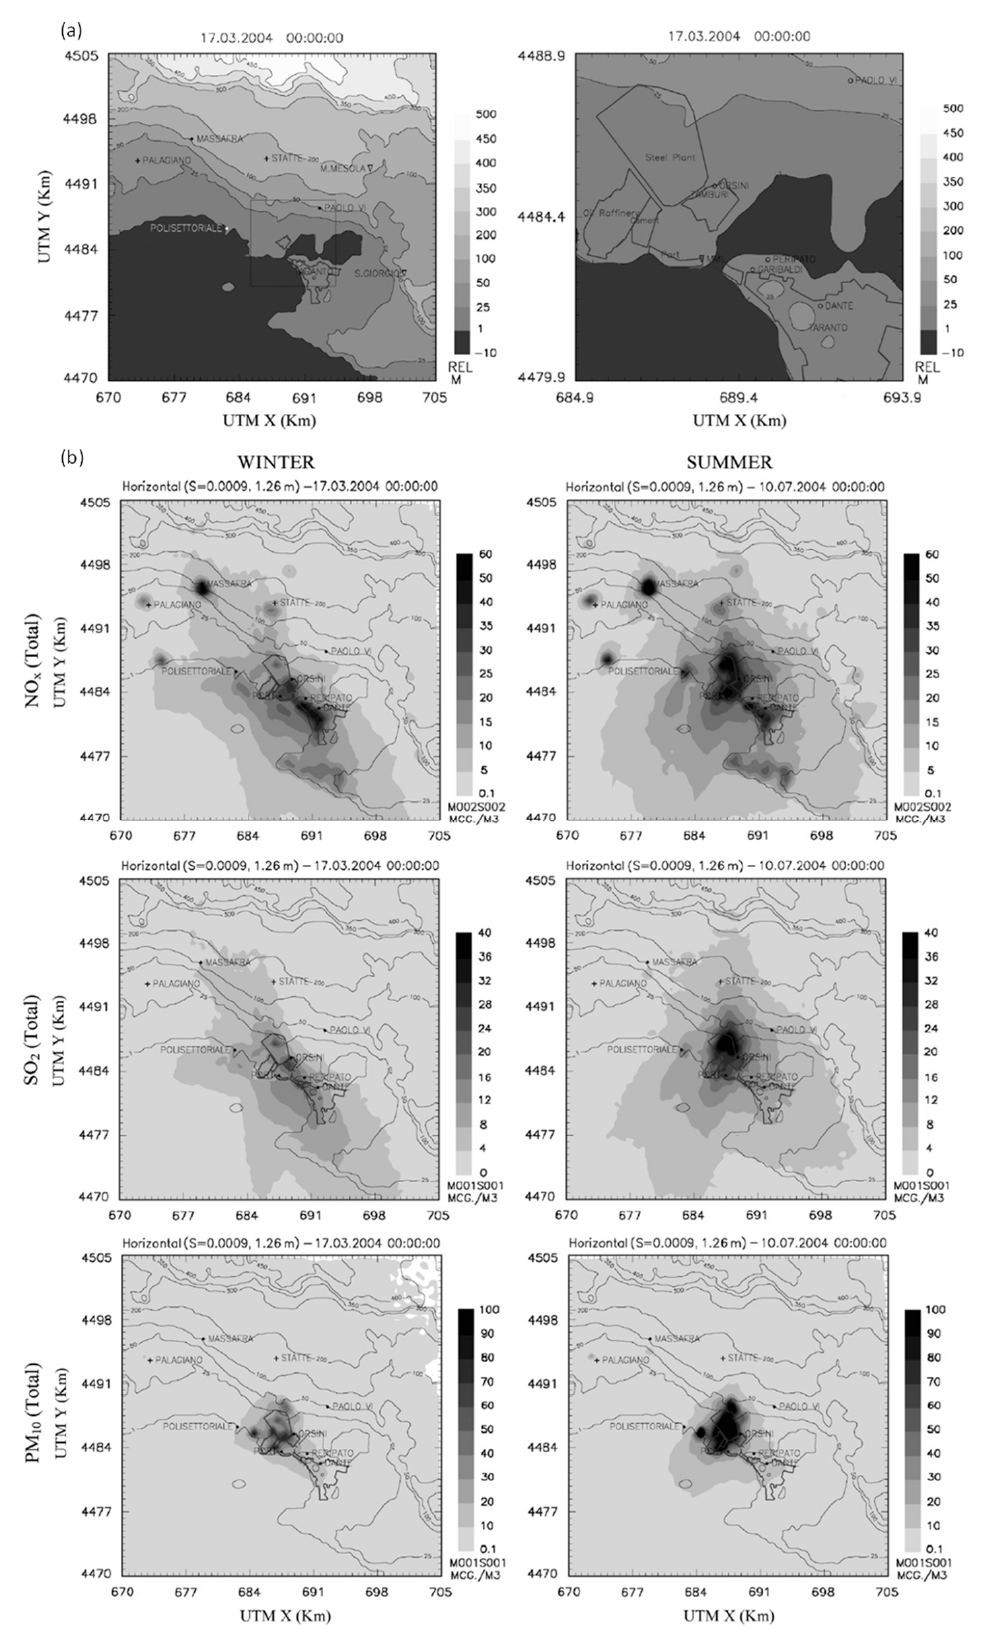
Figure 5. ( a ) Map of the studied area with a large and zoomed view showing location (UTM 33 [Km]) of the monitoring stations and the main industrial harbor and urban areas. ( b ) Average concentration maps of NOx, SO2, and primary PM10, predicted by the SPRAY model in winter and summer seasons